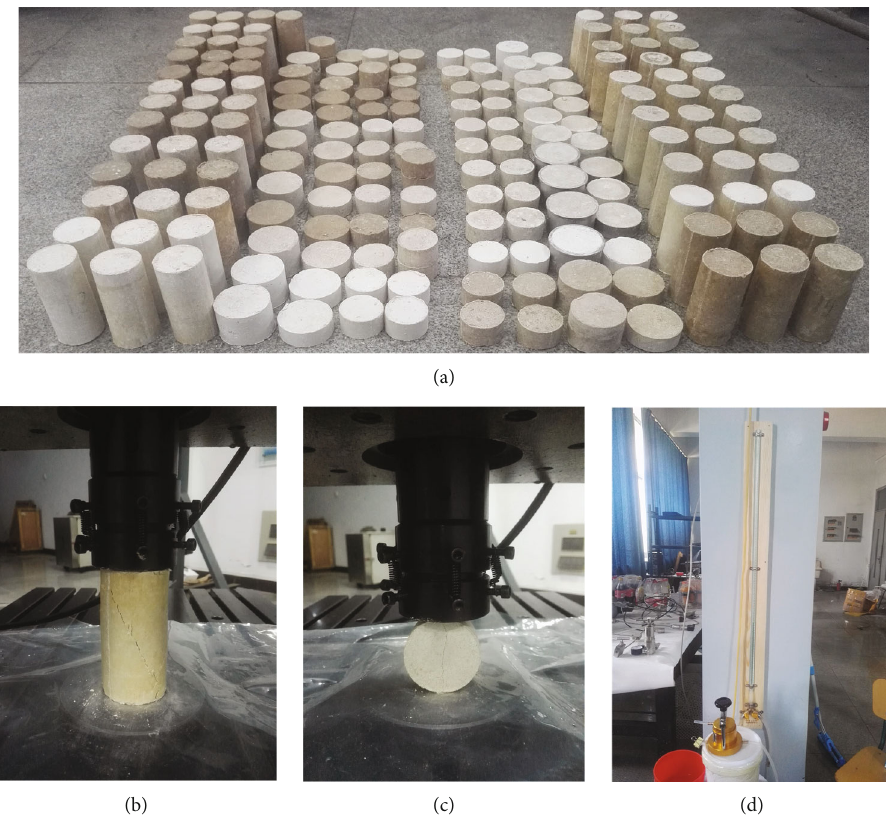
Figure 3: Similarity specimens and tests. (a) Similarity specimens. (b) Uniaxial compression test. (c) Brazilian splitting test. (d) Permeability